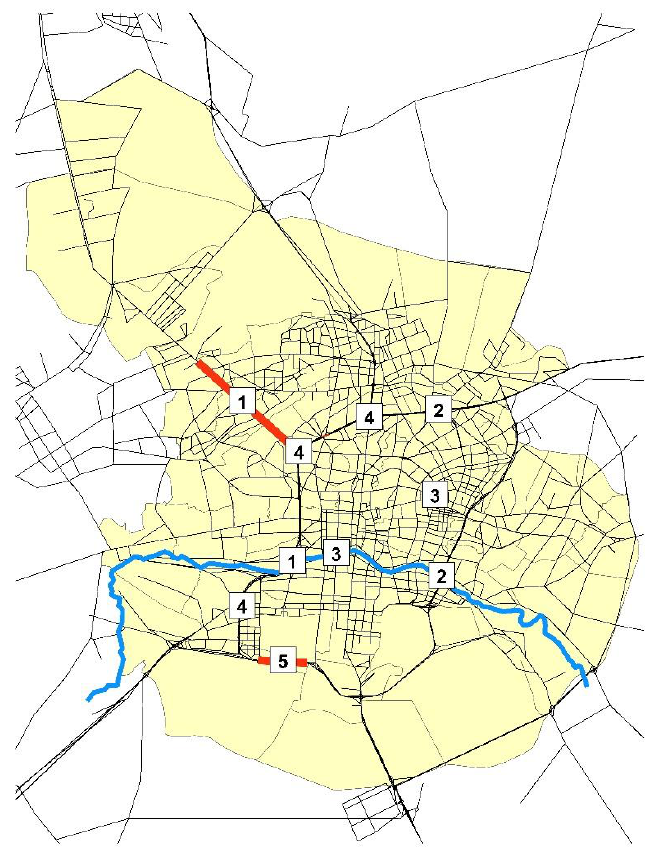
Top 10 most important bridges based on integrated overall and inequity